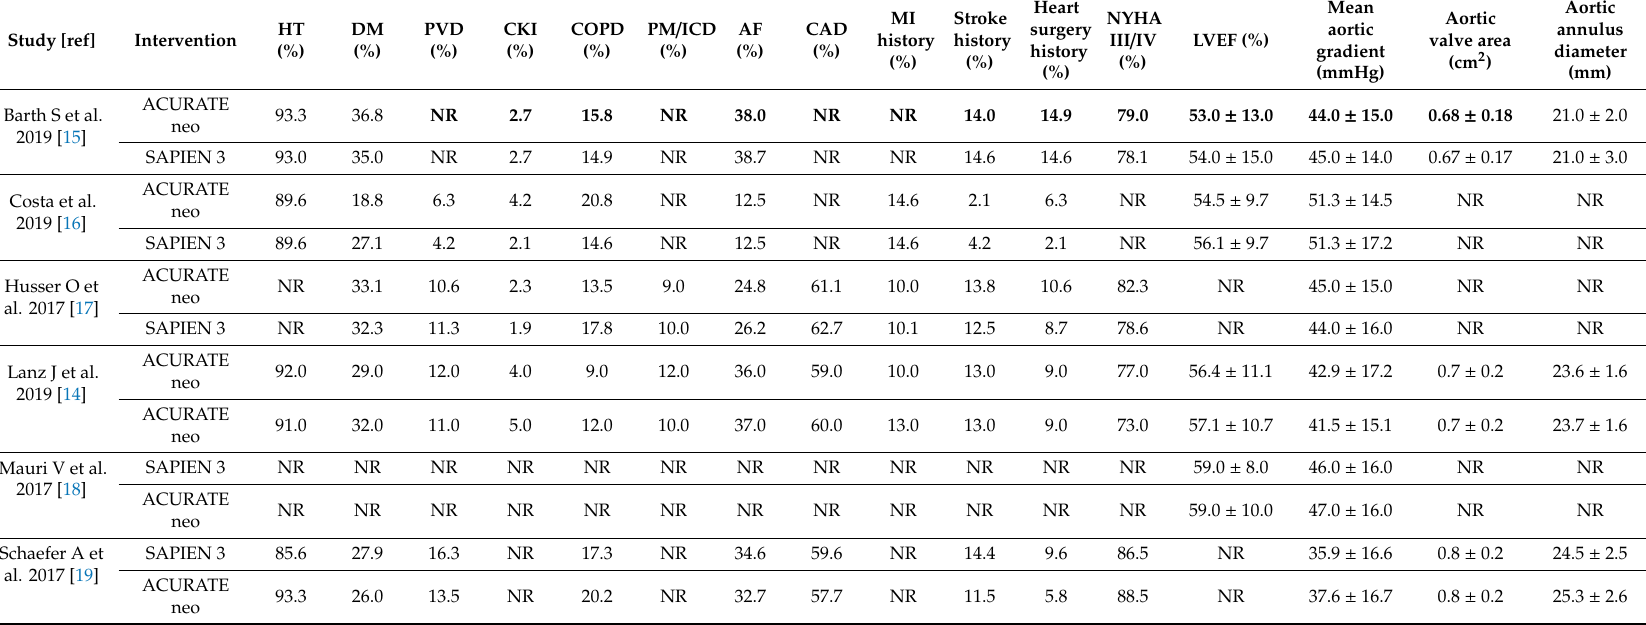
Table A4. Patients’ baseline